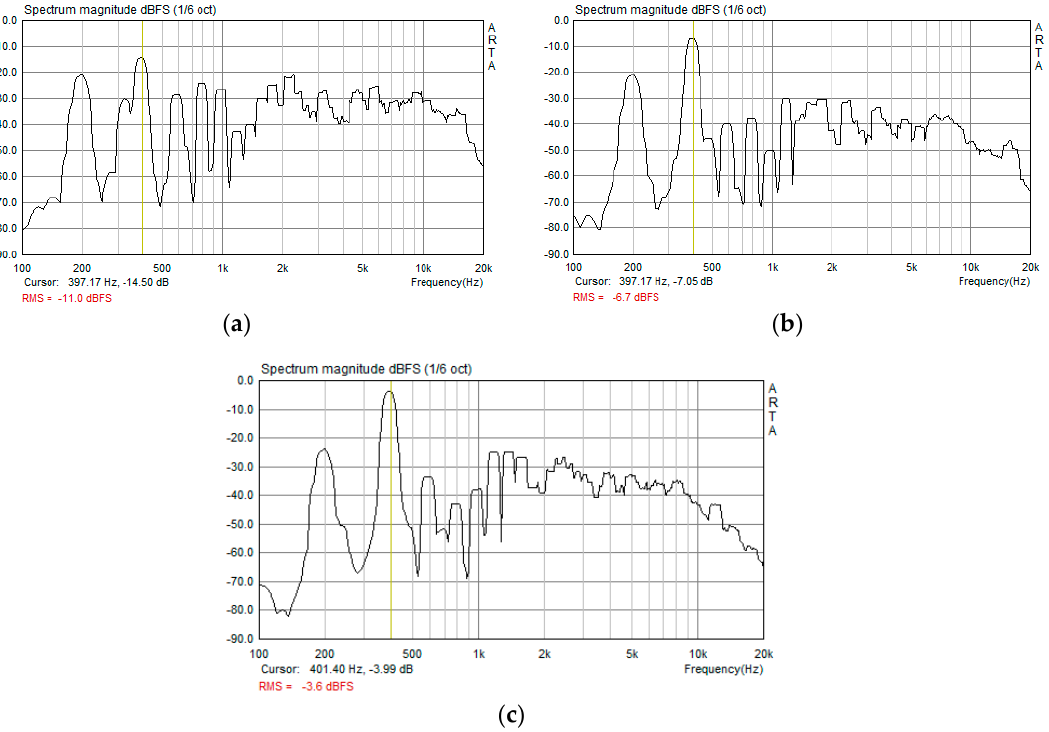
Figure 15. Frequency response of Delroba ( a ), Eshghi ( b ), and Mahava ( c ).